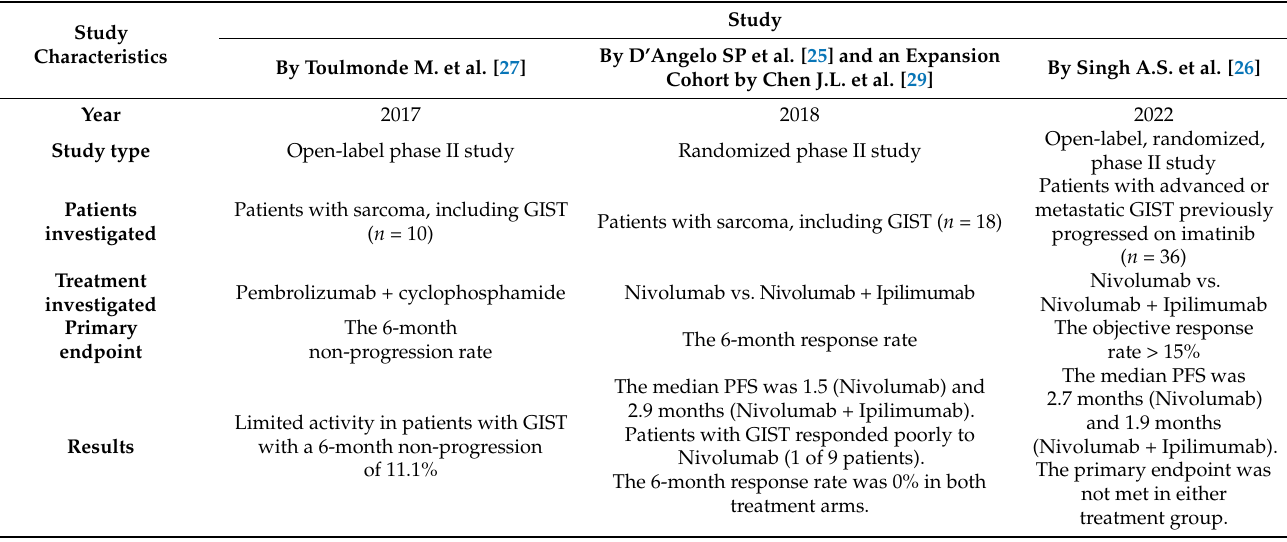
Table 7. Studies investigating treatment with checkpoint inhibitors in patients with